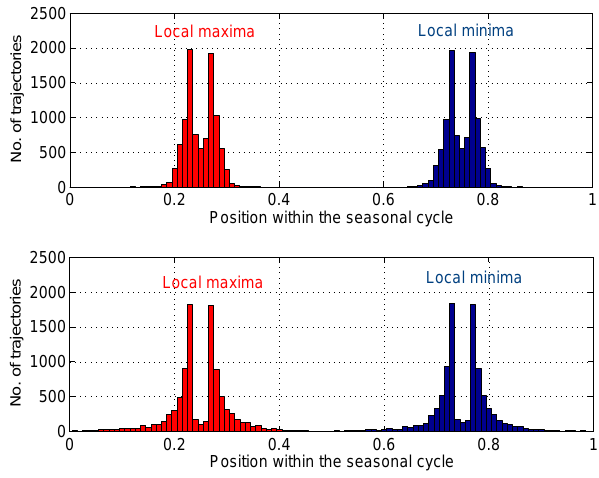
Fig. 5. Seasonal phase locking of local extrema: cumulative results. Histogram of the phase ϕ of the local maxima (red bars) and minima (blue bars) of model solutions with κ = 2 . 0 (top panel) and κ = 11 . 0 (bottom panel). Each panel uses 10000 individual solutions with parameters 0 <τ ≤ 2 and 0 <b ≤ 10; see also Fig. 6.